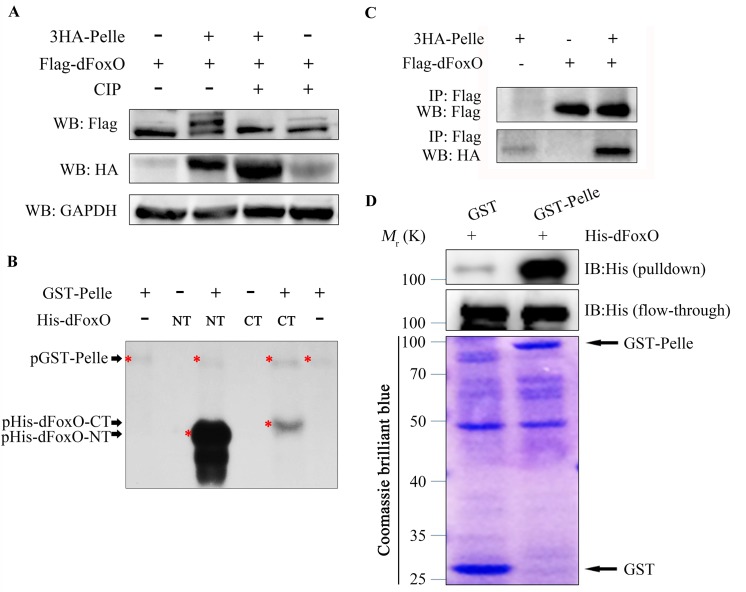
Pll binds to and phosphorylates dFoxO.(A) Expression of Pll induced mobility shift of dFoxO, which was abolished by CIP treatment. Cell lysis was prepared from S2R+ cells expressing Flag-dFoxO alone or with HA-Pelle, treated with or without calf intestine phosphatase (CIP), followed by western blotting. (B) Kinase assay shows Pll phosphorylates the N- and C- terminal parts of dFoxO. (C) Co-immunoprecipitation experiment shows dFoxO interacts with Pelle in S2R+ cells. (D) GST pull-down assay shows direct binding between bacterially expressed His–dFoxO and GST–Pll in vitro.